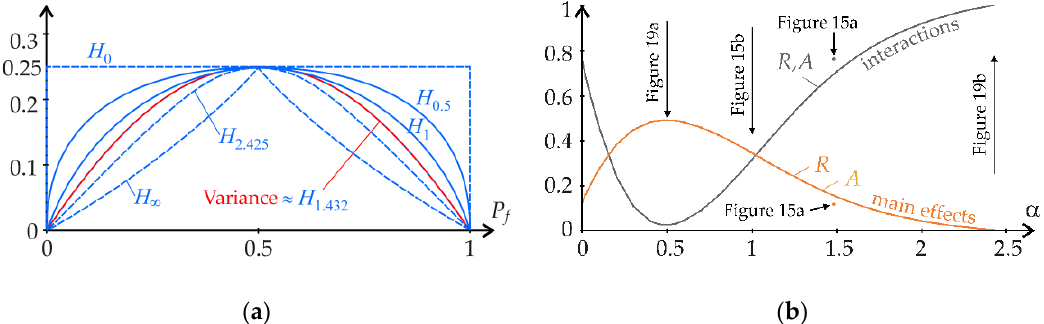
Figure 18. Global sensitivity analysis of P f from Z based on Rényi entropy: ( a ) dependence of Rényi entropy on P f ; ( b ) first- and second-order sensitivity indices of R and A .